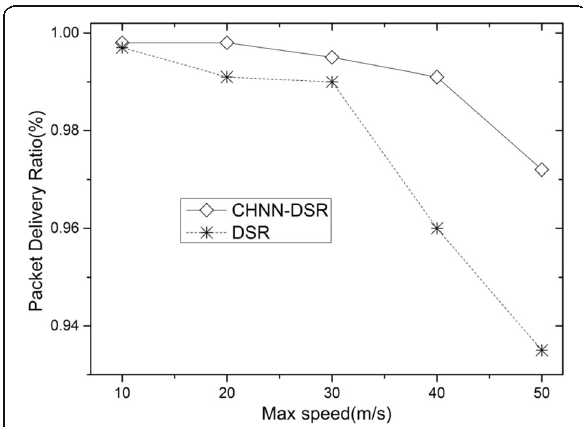
Fig. 4 Packet delivery ratio simulation results for DSR and CHNN- DSR. The simulation results of the packet delivery ratio for CHNN- DSR and DSR under the change of node movement speed